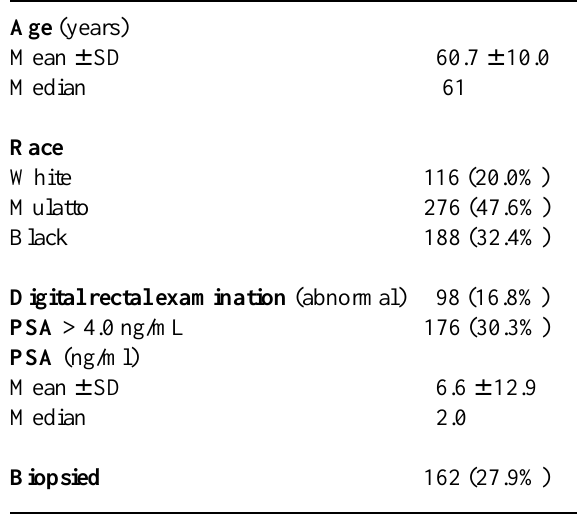
Table 1 – Demographic and clinical data of 580